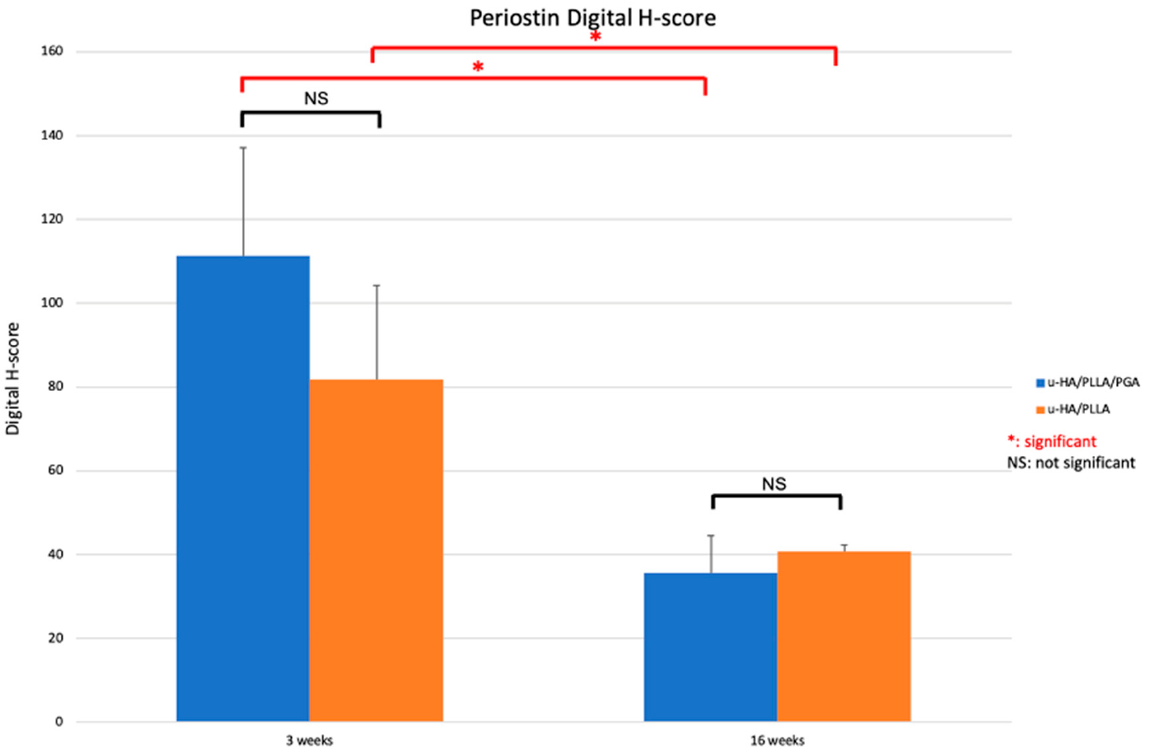
Figure 13. Digital H-scores based on IHC staining using an anti-periostin antibody in the u-HA/PLLA/PGA and u- HA/PLLA subgroups. * p < 0.05.